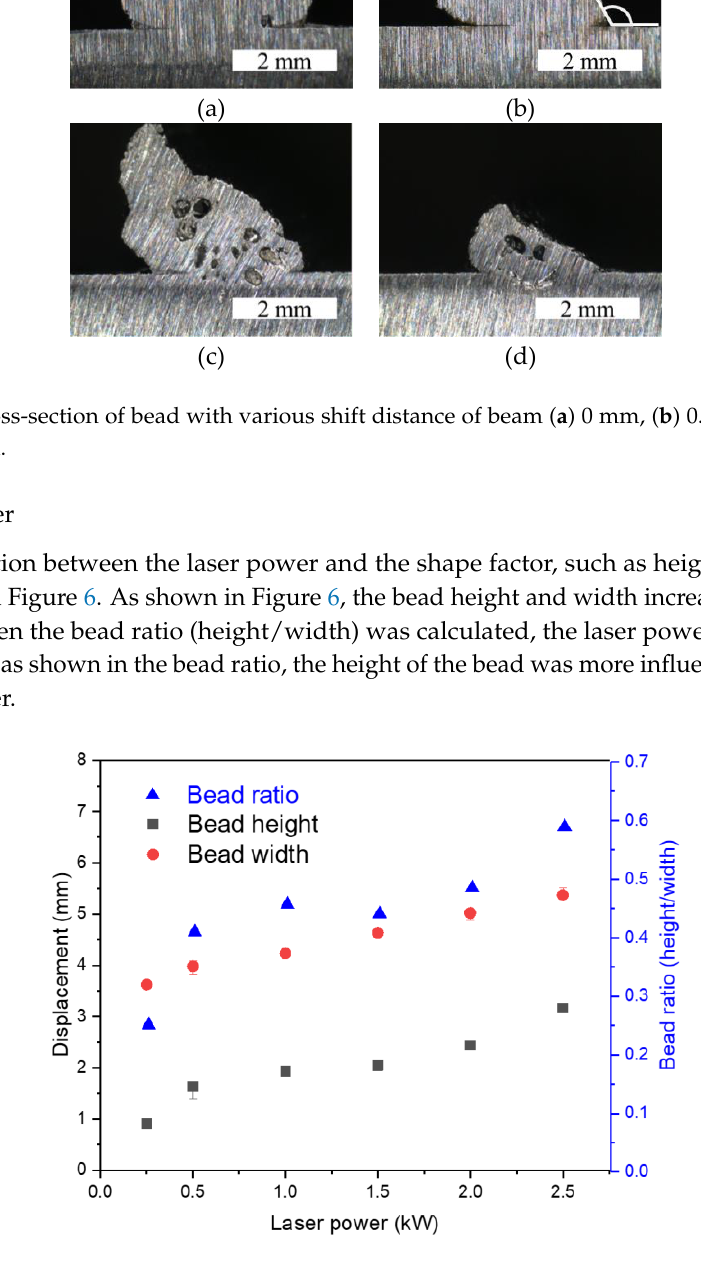
Figure 4. Schematic diagram of beam alignment: ( a ) center beam, ( b ) 0.5 mm shifted beam.